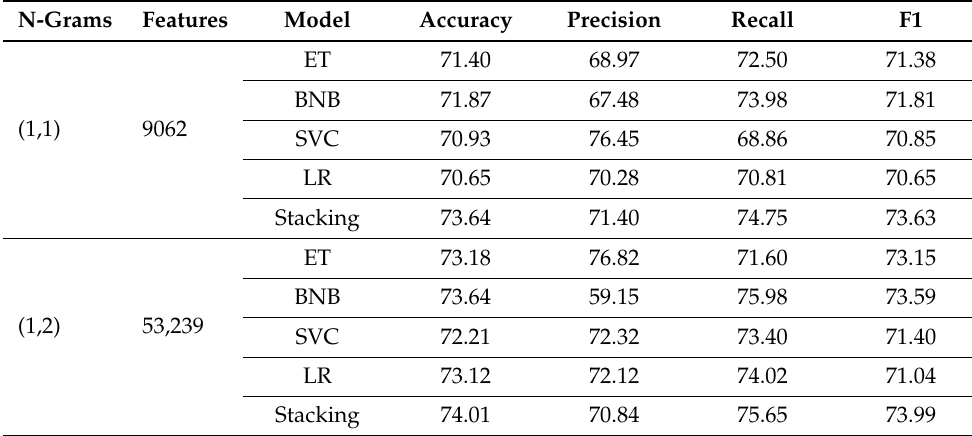
Figure 3. ROC using BoW features. Table 10. Threatening language detection using TF-IDF features.